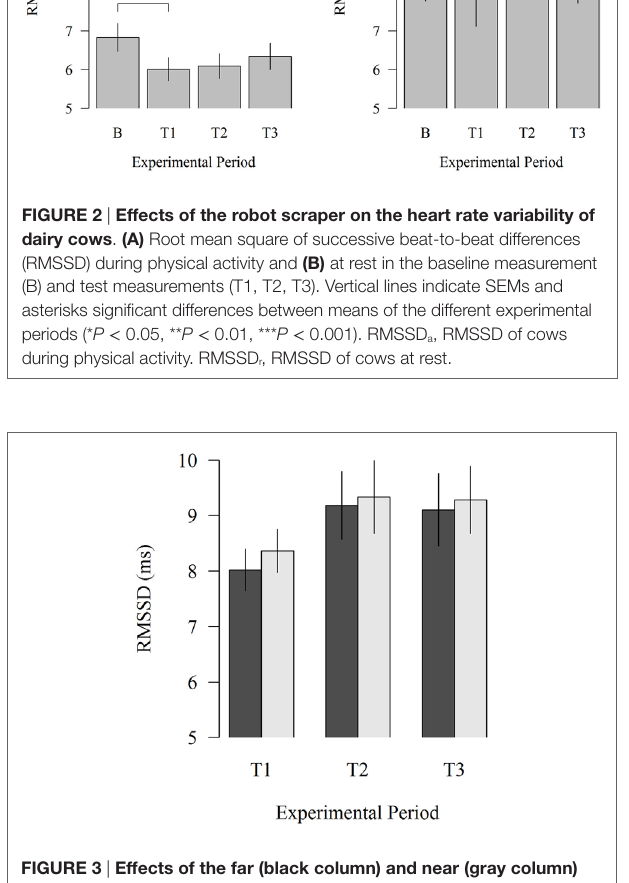
FigUre 3 | effects of the far (black column) and near (gray column) distance of the moving robot scraper on the hrV of lying cows during the experimental periods T1, T2, and T3 . Vertical lines indicate SEMs.